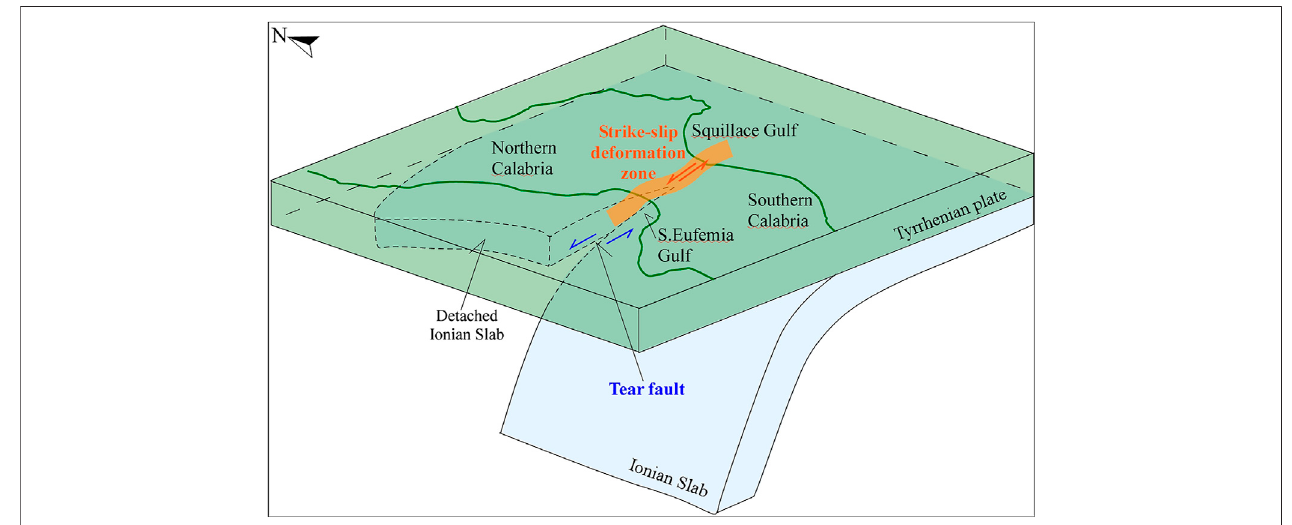
FIGURE 10 | Geodynamic sketch of the Tyrrhenian-Ionian subduction system illustrating the strike-slip deformation zone extending from Sant ’ Eufemia Gulf to Squillace Gulf formed above the tear fault inferred between two segments of the Ionian slab.